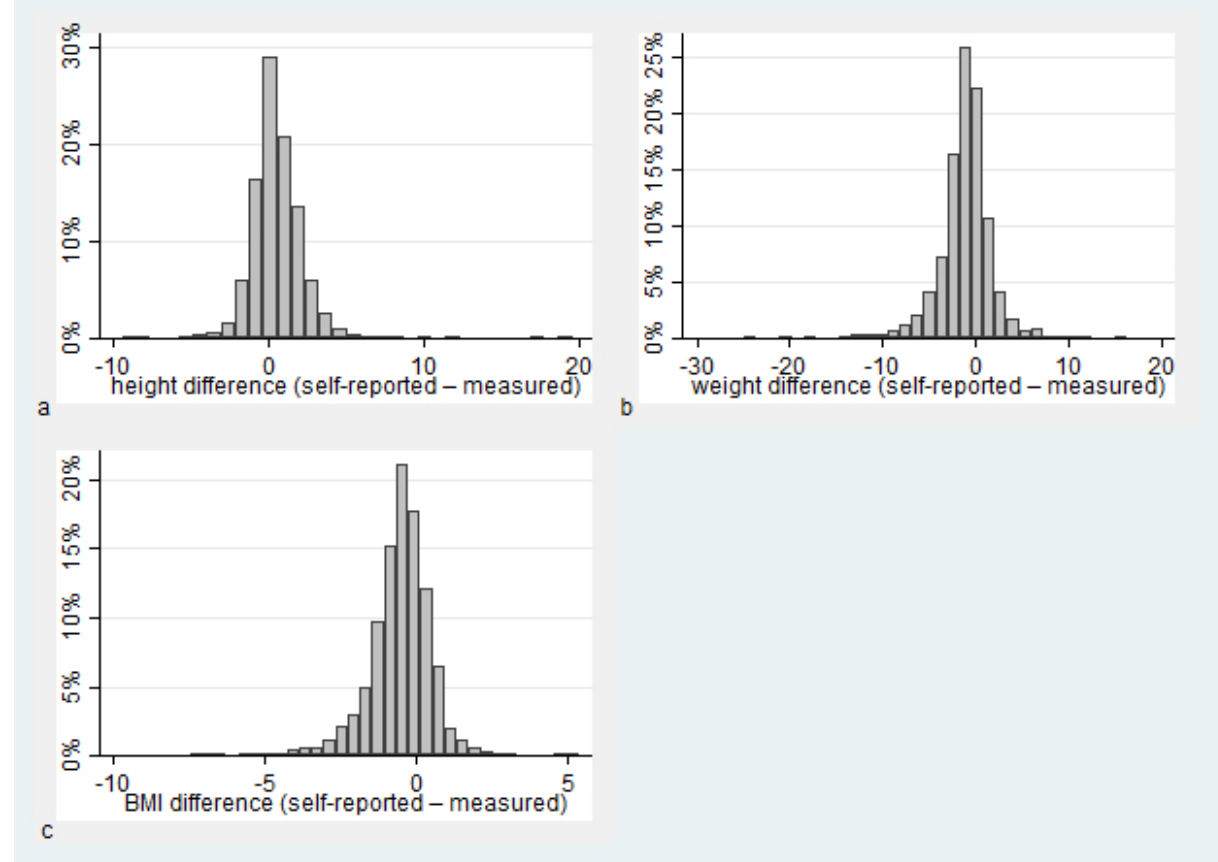
Figure 1. Histogram of difference between self-reported and measured a) height, b) weight, and c) BMI.